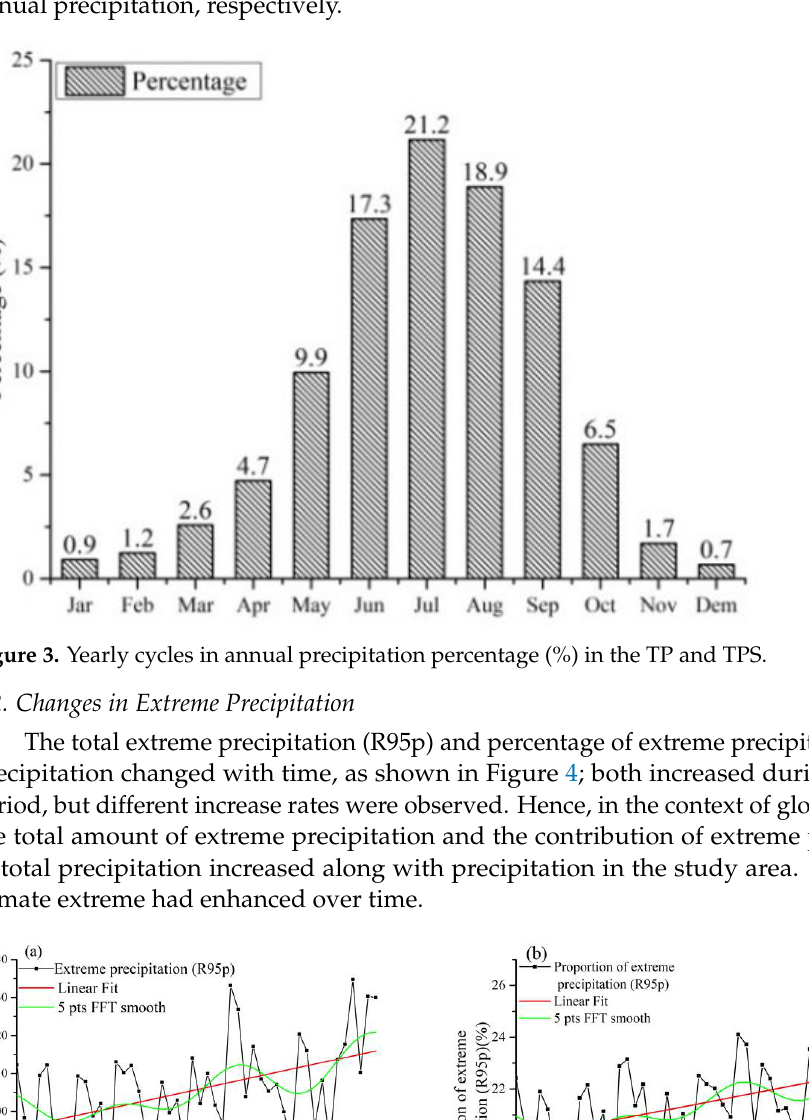
Figure 4. Changes in total extreme precipitation (R95p)( a ) and extreme precipitation percentage change( b ) in the TP and TPS during 1971–2017.The rate of increase was 4.3 mm/decade slope(0.43; R: 0.45; Figure 4a) for extreme precipitation, and the rate of increase was 0.59%/decade (slope: 0.0059; R: 0.49; Figure 4b) for extreme precipitation percentage. The spatial trends of R95p are shown in Figure 5a. Spatial heterogeneity in R95p was observed in the study area. R95p gradually decreased from southeast to northwest, which was consistent with the spatial variation trend of precipitation. The spatial distribution of the R95p was consistent with the spatial distribution of the annual total PRCPTOT (as Figures 5a and Figures 2a). Notable regional differences were observed; most stations ex- hibited significant increasing trends, while 33 stations in the study area exhibited decreas- ing trends. These stations were relatively concentrated in the southeast of the TP. This also means that under the background of global warming, it was more complicated in the trend of extreme precipitation in the plateaus and mountainous areas. Maybe this indicates that warming-related changes vary according to region.